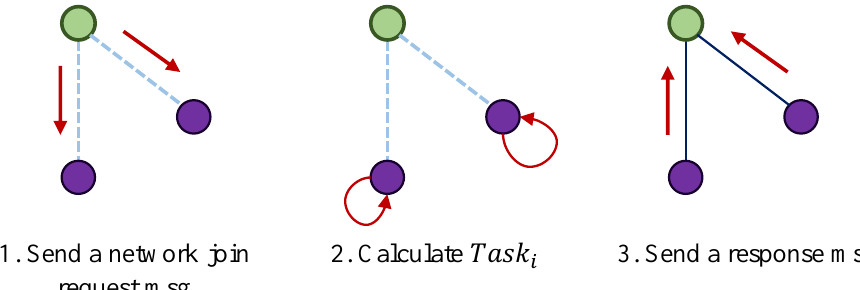
Figure 3. Sequence of network join